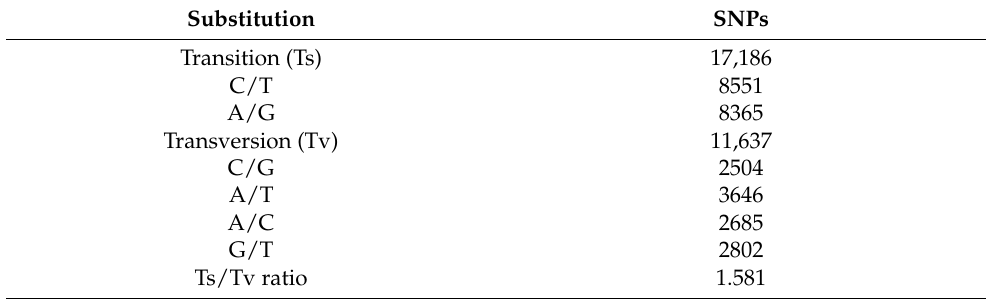
Table 2. Transition and transversion for SNPs identified in 110 common bean accessions evaluated in this